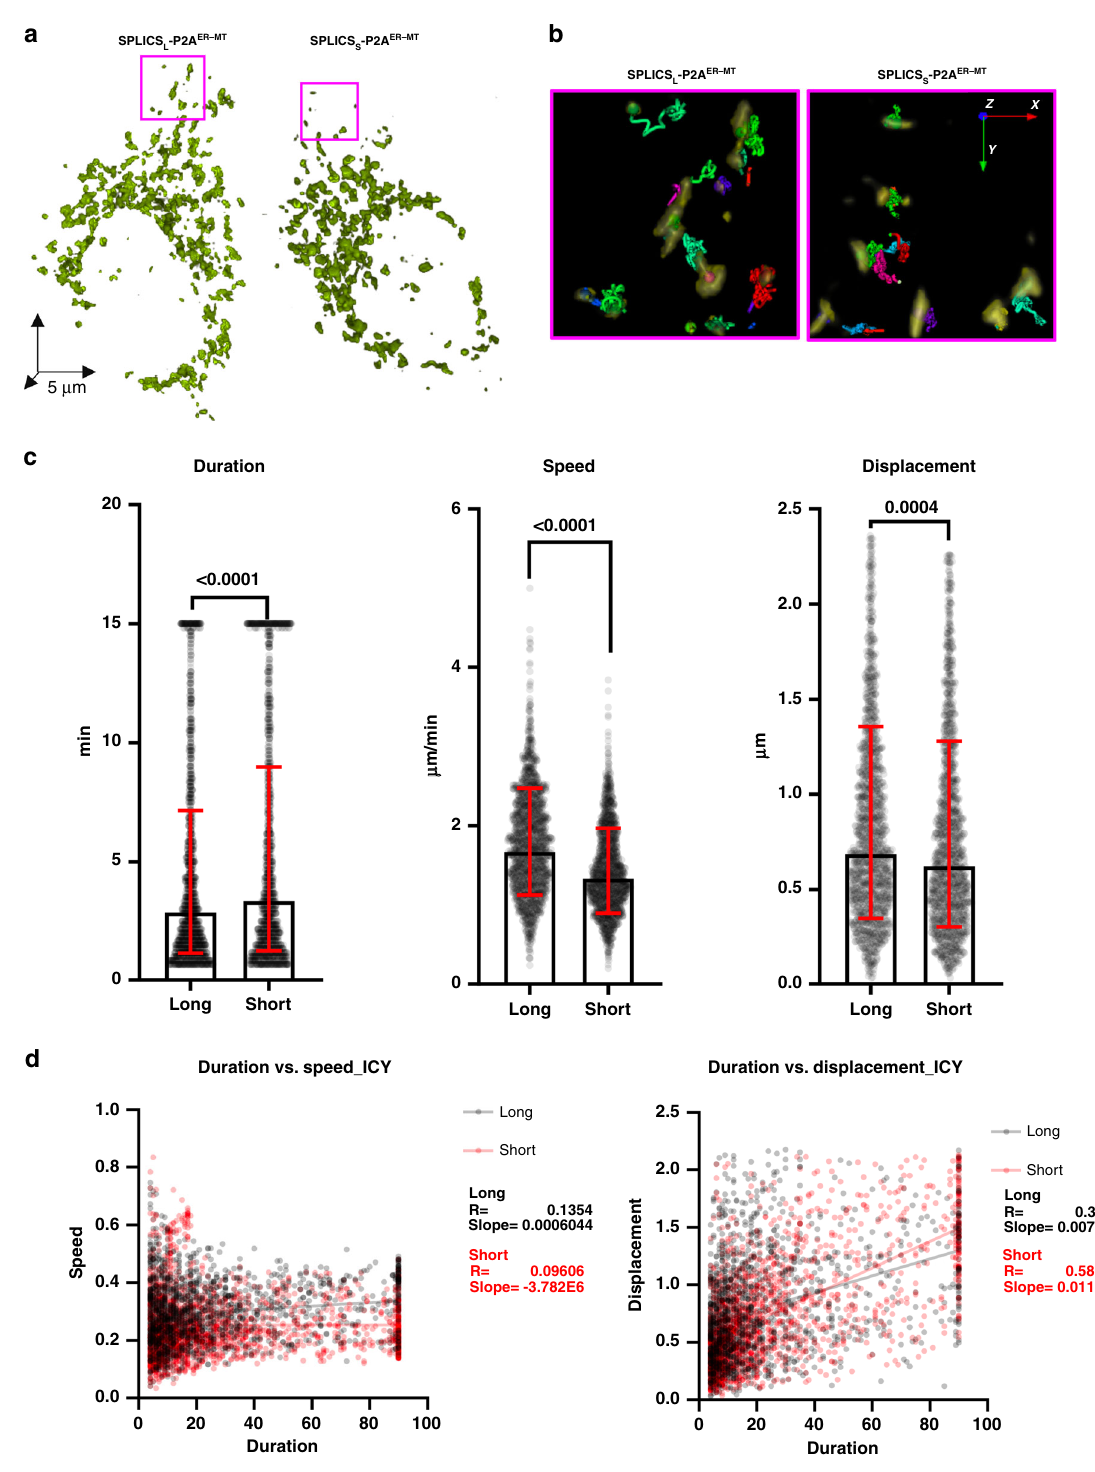
Fig. 6 ER – mitochondria contact sites are dynamic structures in cultured cells. a Representative rendering of HeLa cells expressing SPLICS S P2A ER – MT (left panel) or SPLICS L P2A ER – MT (right panel). b Representative isosurface rendering of tracks obtained by the Icy method of cropped areas from a . Tracks are color coded to represent track ID. c Tracks quantitative analysis obtained by the Icy method of track duration ( n = 1645 long and 1504 short tracks from six cells), speed ( n = 1671 long and 1502 short tracks from six cells) and displacement ( n = 1461 long and 1395 short tracks from six cells), geometric mean ± geometric SD. d Duration/speed and Duration/displacement correlation obtained by the Icy method. The Parson coef fi cient and the slope are indicated for the long- and short-range ER – mitochondria contact sites, respectively. Data shown are the result of three independent transfections. (Mann – Whitney or Kolmgorov – Smirnov tests). Source data are provided as a source data fi